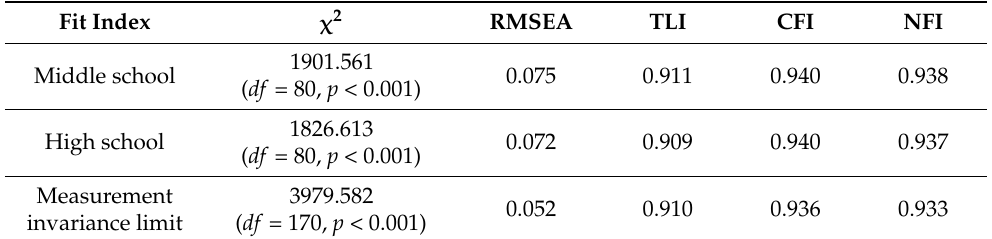
Table 3. Middle and High School Student Group Models’ Goodness-of-fit